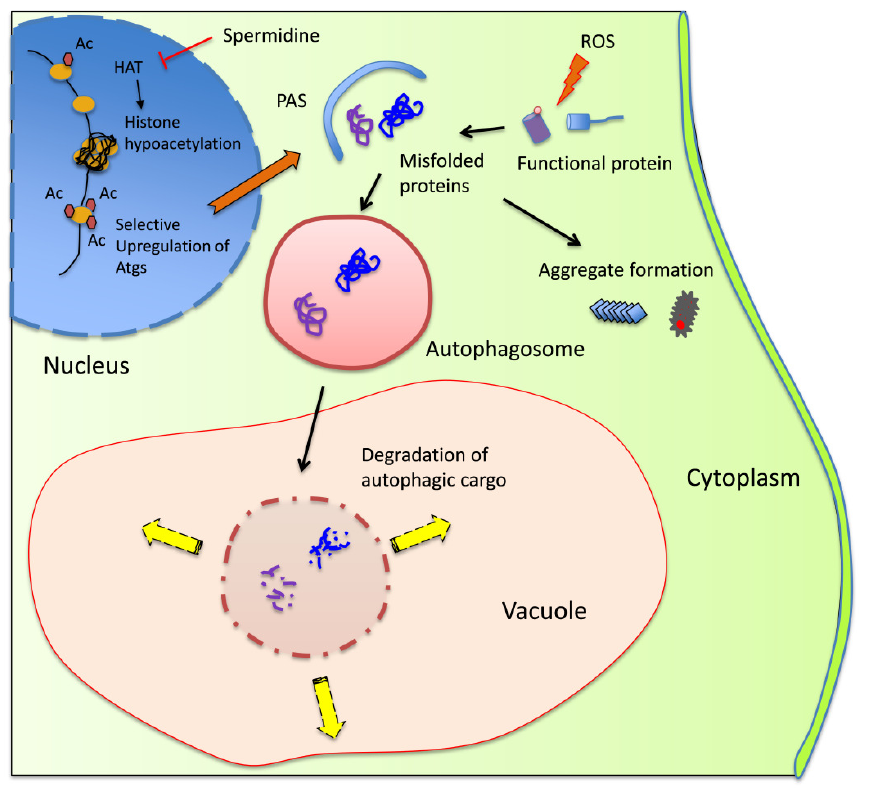
FIGURE 1: Model illustrating the cytoprotective action of spermidine in preventing spontaneous prion formation. Spermidine inhibits the activity of histone acetyl